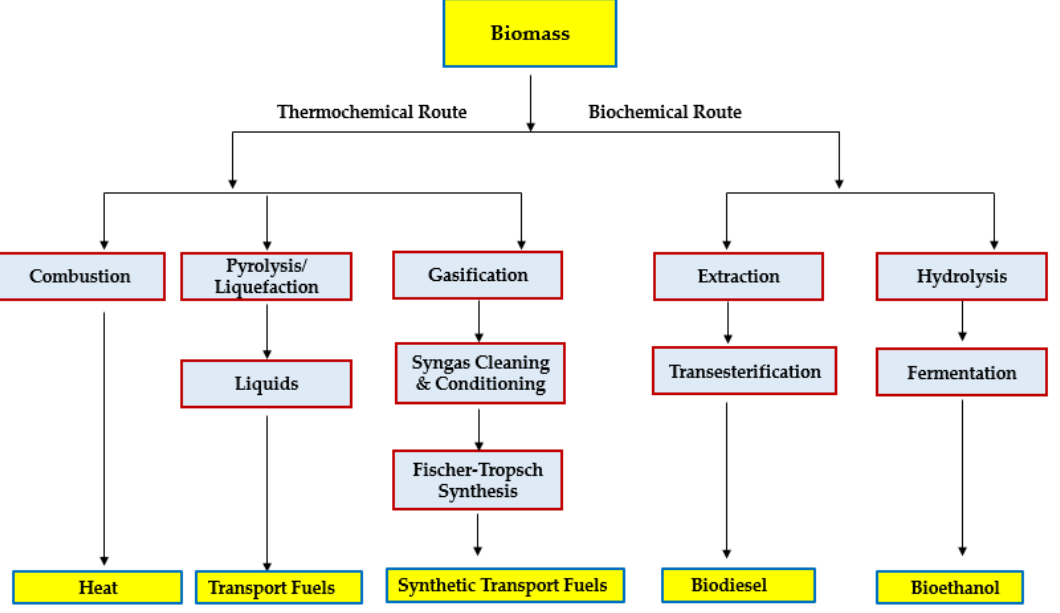
Figure 1. A simplified schematic illustration of two main biofuel production pathways (adapted from [15]).